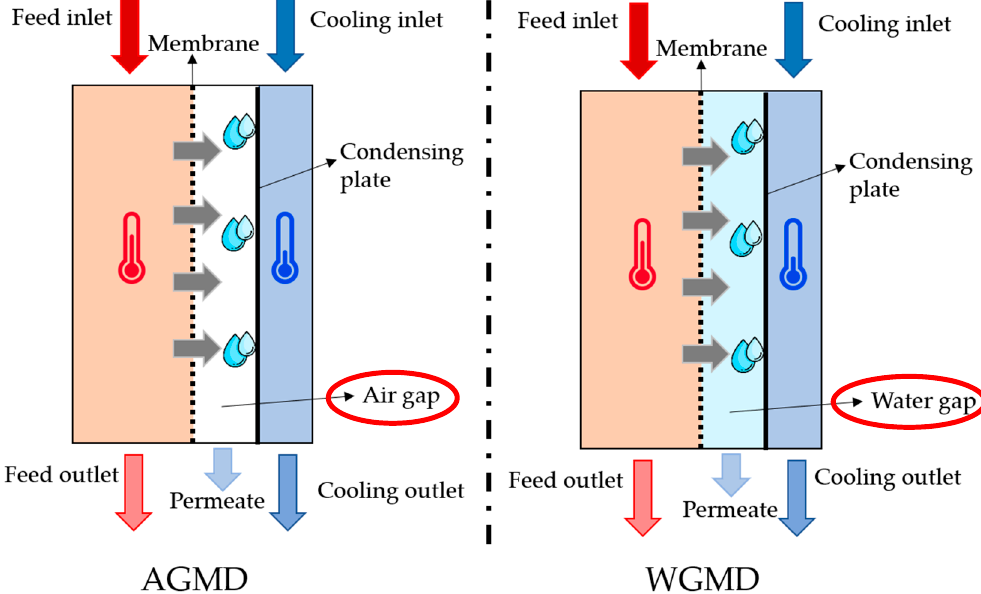
Figure 1. Scheme of air gap membrane distillation (AGMD) and water gap membrane distillation (WGMD) configurations in co-current mode.